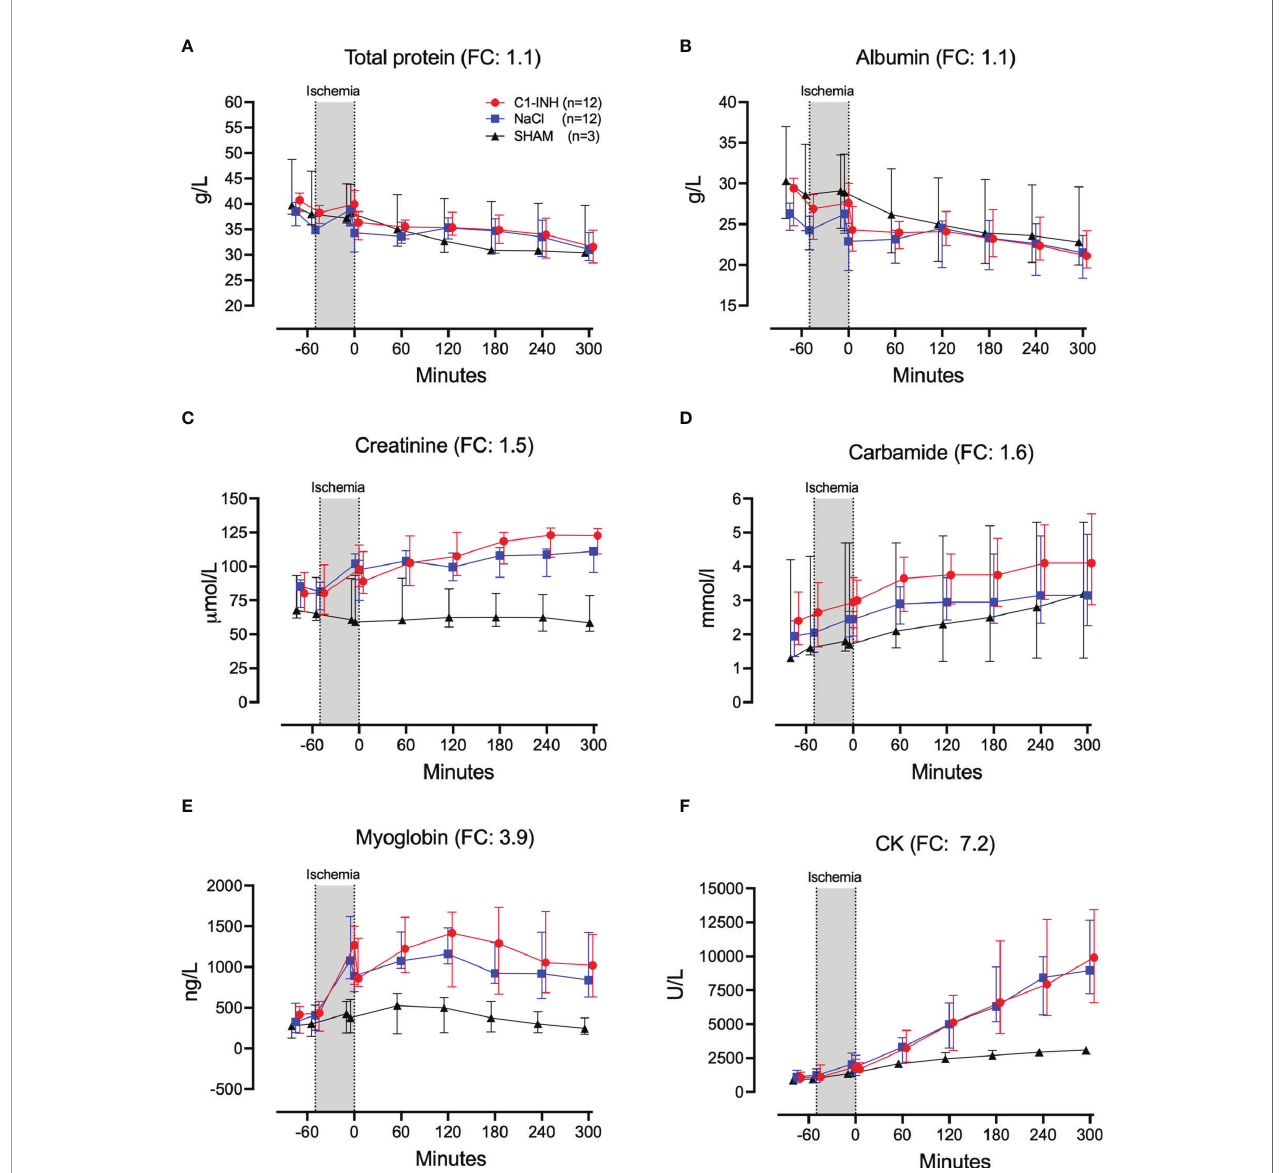
FIGURE 7 | Biochemical and organ damage markers I. (A) Total protein, (B) albumin, (C) creatinine, (D) carbamide, (E) myoglobin, and (F) creatine kinase (CK) were measured in serum of 24 piglet undergoing clamping of the thoracic aorta at the Th8 level. Upfront 12 piglets received human saline intravenously and 12 received C1-INH (250 IU/kg), respectively. Three sham animals received thoracic opening without clamping. Reperfusion started at 0 minutes and lasted 5 hours. Longitudinal time data are expressed as median and interquartile range. “ Ischemia ” indicates the 45 minutes period of clamping. NaCl and C1-INH-groups were combined when there were no differences in the fold change (FC) calculation. FC is the change from before cross-clamp onset to maximum